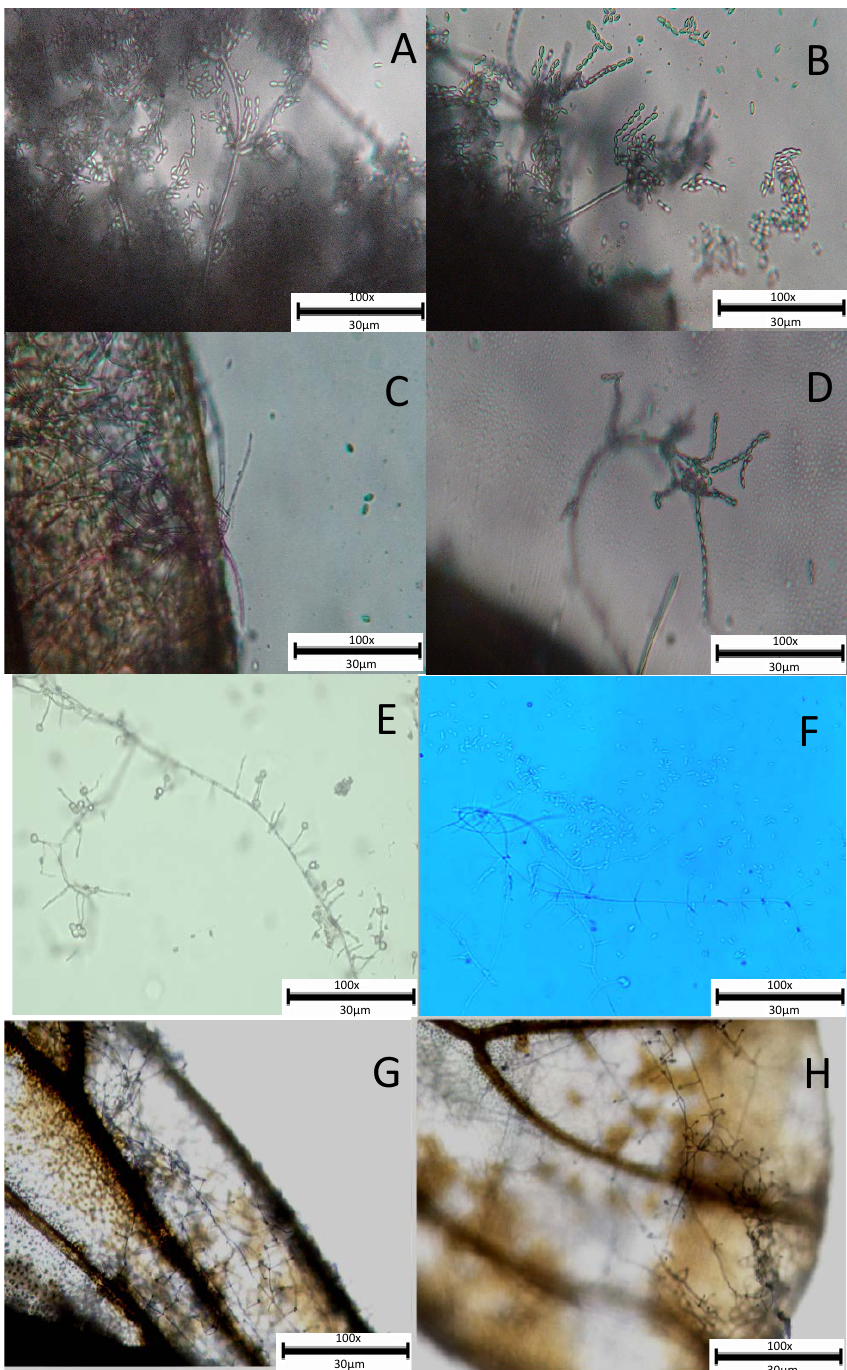
Figure 6. Light microscopic picture of Cja Apopka 97 hyphae and conidia, outgrowth from infected adult Diaphorina citri ( A ) vertically branched conidiophore with conidia dispersing from D. citri adult cadaver; ( B ) dense conidia and hyphae extending from the edge of the psyllid body (aerial conidial dispersal); ( C ) hyphae growing on the wing surface of infected psyllid; hyphae growing through the veins and forming mycelium; (D) hyphae and conidia growing on phialides extending from infected insect; ( E, F ) hyphae and conidia growing on phialides and dispersing from infected insect (aerial conidial dispersal); ( G ) hyphae growing on the infected psyllid wing surface; ( H ) hyphae with conidia growing on phialides on wing surface.